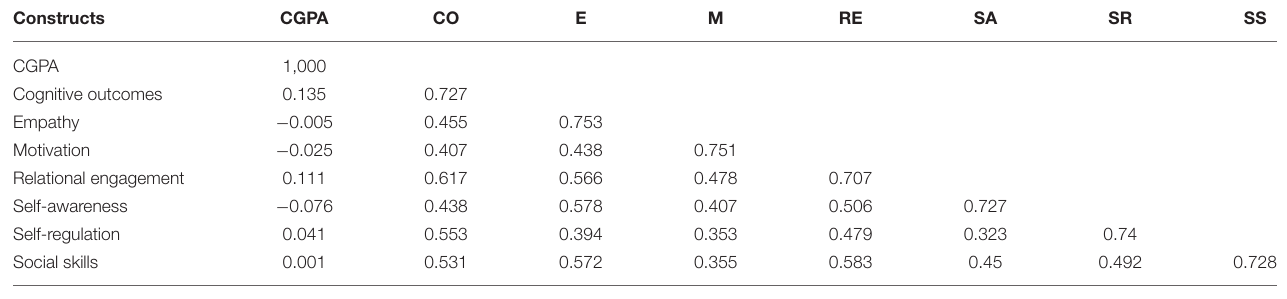
TABLE 4 | Descriptive